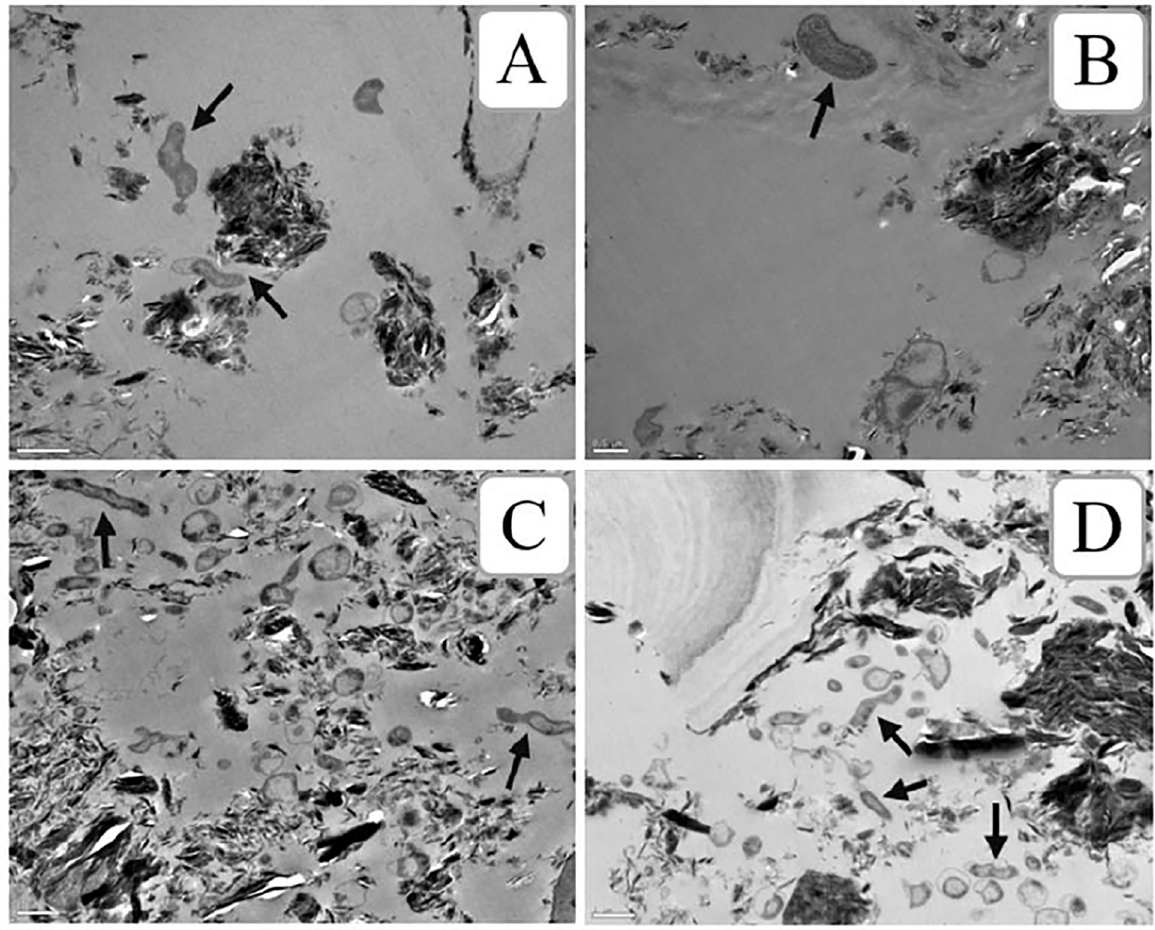
Fig 4. Transmission electron micrographs of cells of Campylobacter spp. after exposure to cooking salt at different time intervals showed spiral shaped cells even after 6 hours of exposure. A) immediately after inoculation; B, 60 min; C, 180 min; D; 6 hours. Arrows represent bacterial cells with typical spiral shape of Campylobacter spp. Amplifications: A) 15000X; B) 20000X; C) 12000X; and D) 12000X. Bar represents 1 μ m in Fig 4A), 4C) and 4D) and 0.5 μ m in Fig 4B).